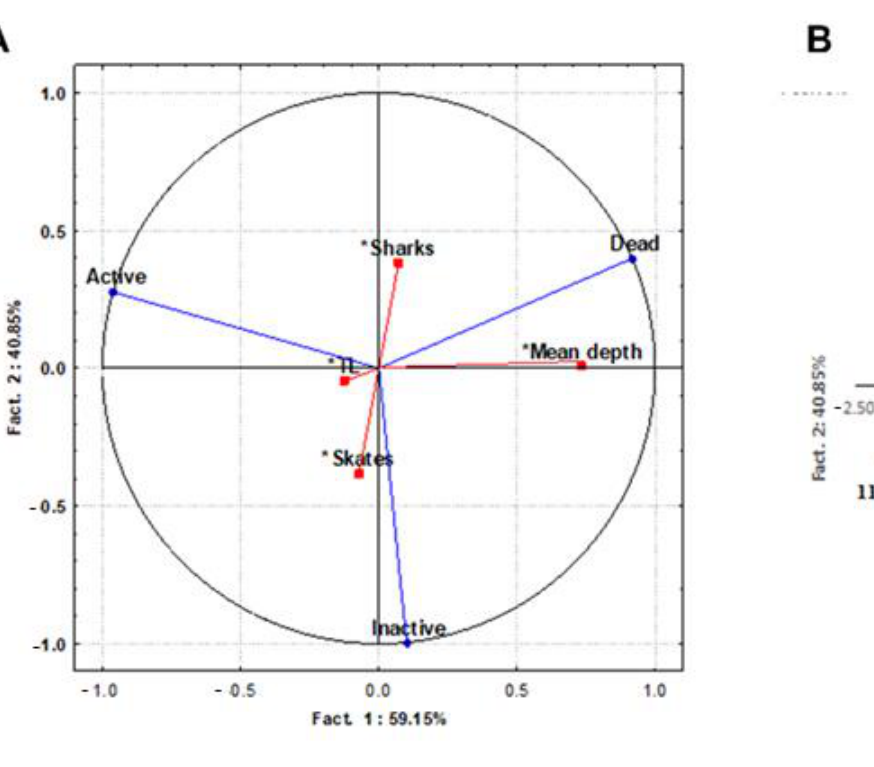
Figure 6. ( A ): Projection of active (active, inactive, and dead, as blue vectors) and supplementary (red asterisked vectors (*): catch mean depth, fish size as TL (total length), and skates and sharks, as taxonomical groups) variables on 1 × 2 factorial plane of principal component analysis used to investigate the differences in the vitality rates observed in twelve species of demersal elasmobranchs after trawl catch. ( B ): Projection of weighed mean of species coordinates on a 1 × 2 factorial plane together with vector variables. Note that factorial planes of the variables and cases refer to different coordinate systems such that the representation of vector variables in the cases’ plane provides qualitative information. Note that the length of supplementary vectors and the angle between them and active vectors are directly and inversely proportional to the average correlation between supplementary vectors and extracted components and between active and supplementary vectors, respectively. The species icons refer to Leucoraja circularis (1), Mustelus mustelus (2), Scyliorhinus canicula (3), Galeus melastomus (4 ), Etmopterus spinax (5), Dipturus oxyrinchus (6), Raja polystigma (7), Leucoraja fullonica (8), R. miraletus (9), Squalus acanthias (10), R. brachyura (11), and R. montagui (12) sampled during a fishery-independent trawl survey in the Asinara Gulf during June – October 2022. The species icons are modified from Barone M., Mazzoldi C., and Serena F. (2022) [79].